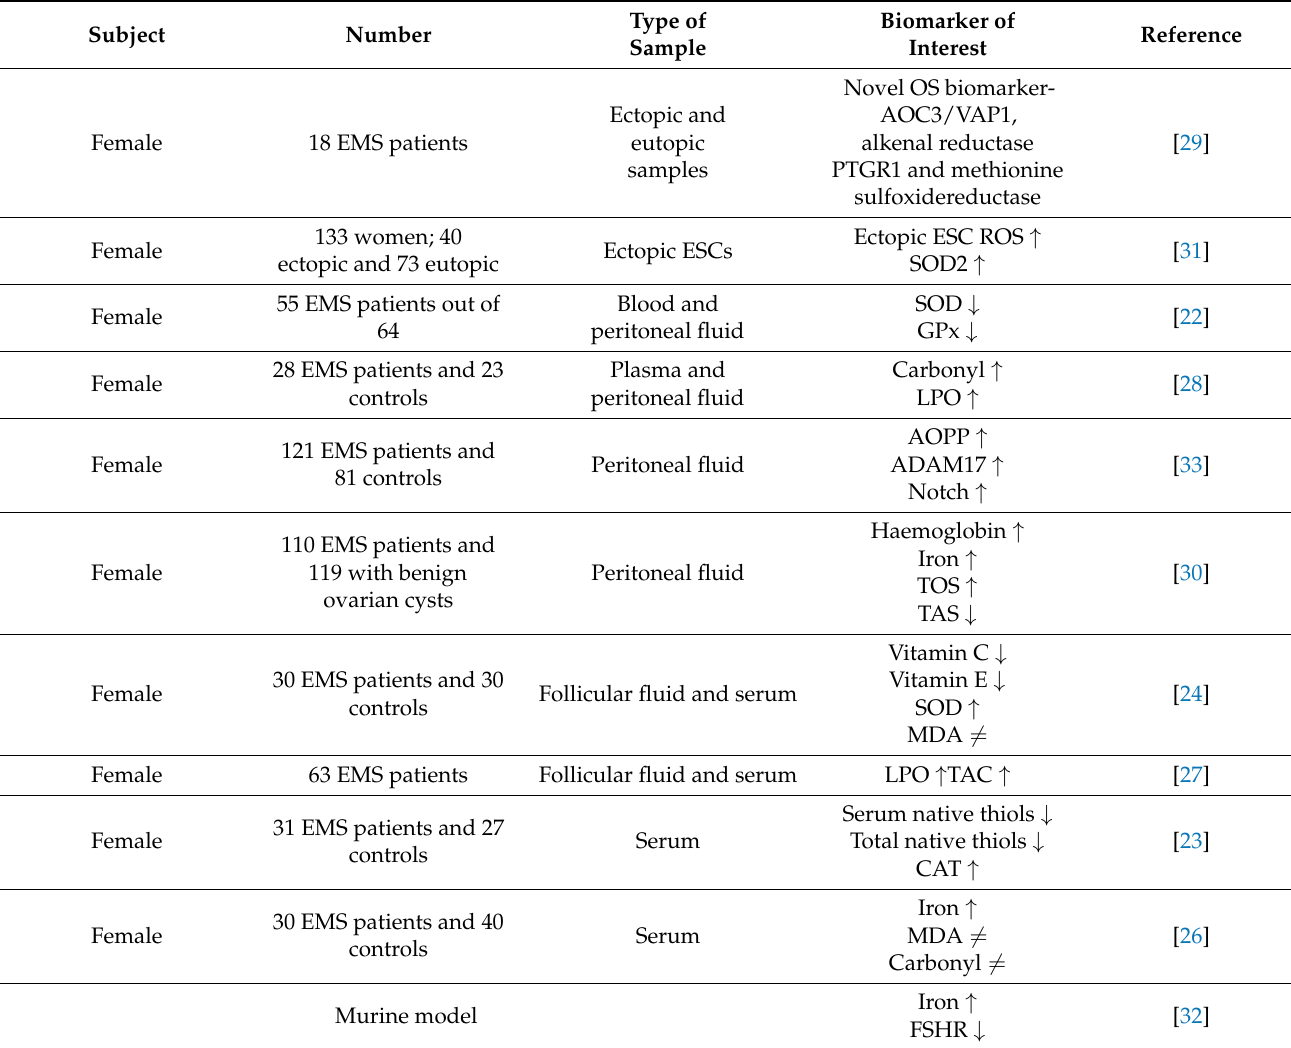
Table 1. Summary content regarding the outcomes in which we investigated the oxidative and potential